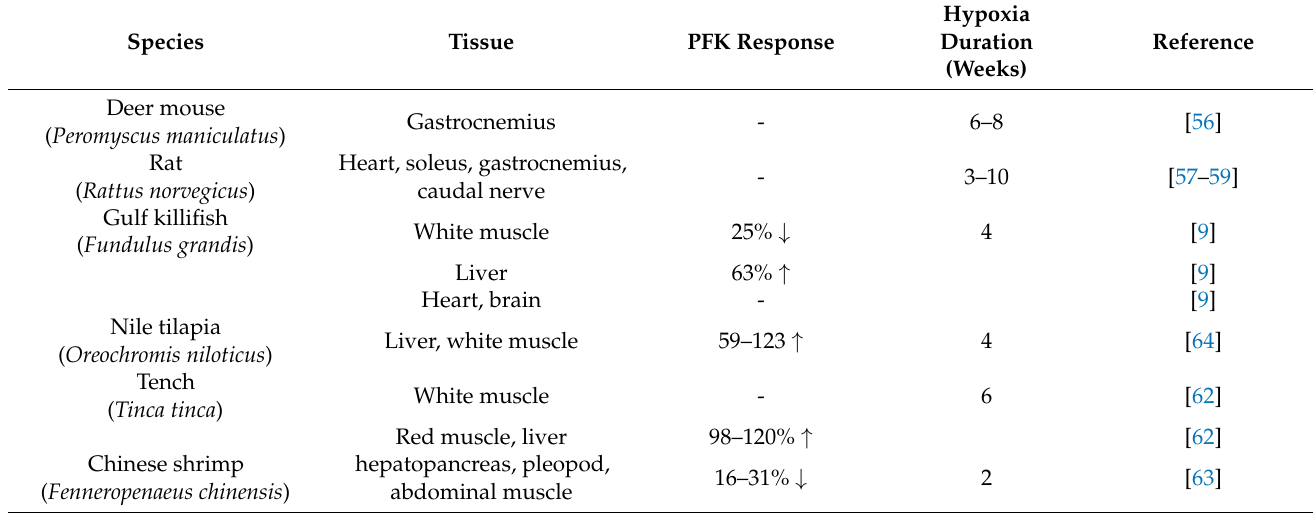
Table 3. Effects of chronic hypoxia (minimum 1 week) on the maximal activity of phosphofructokinase (PFK) in various